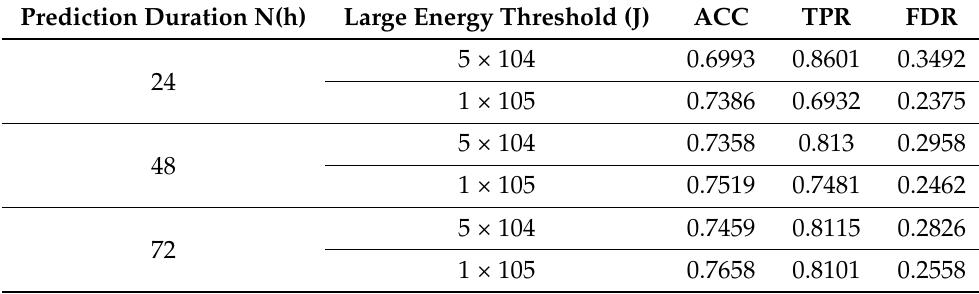
Table 3. Influence of prediction